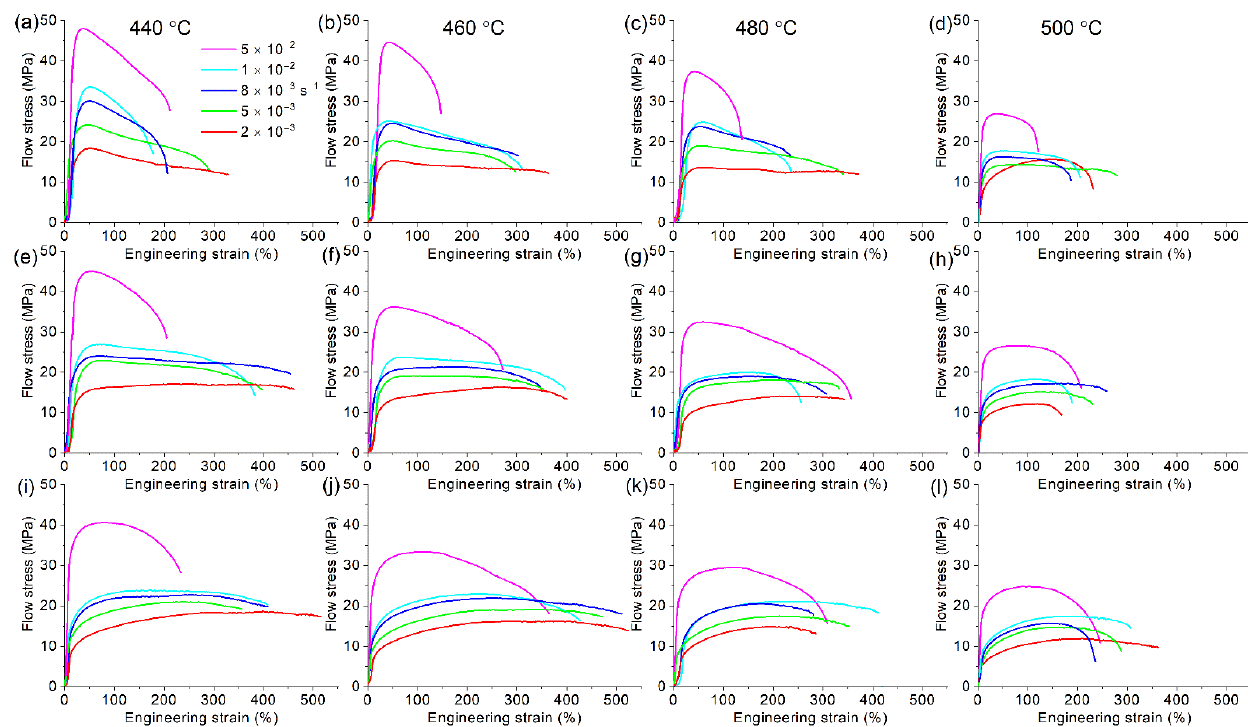
Figure 10. The flow stress-strain dependences for the ( a – d ) alloy 1 (Al-1.2Mg-0.7Si-1.0Cu-0.5Ni), ( e – h ) alloy 2 (Al-1.2Mg- 0.7Si-1.0Cu-2Ni), and ( i – l ) alloy 3 (Al-1.2Mg-0.7Si-1.0Cu-4Ni) in a strain rate range of 2 × 10 −3 s −1 –5 × 10 −2 s −1 and temperatures of ( a , e , i ) 440 °C, ( b , f , j ) 460 °C, ( c , g , k ) 480 °C, and ( d , h , l ) 500 °C.